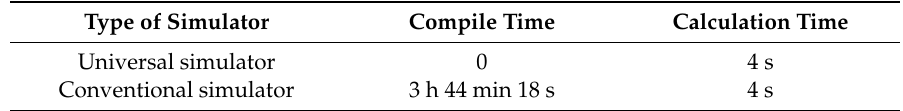
Table 1. Comparison of simulation time between the universal FPGA-based real-time simulator and the conventional FPGA-based real-time simulator.